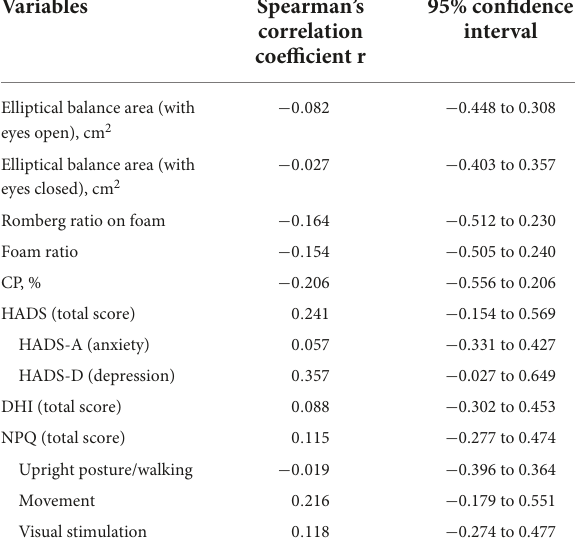
TABLE 4 Correlation between post/pre-bivariate contour ellipse area ratio and clinical parameters in the persistent postural-perceptual dizziness